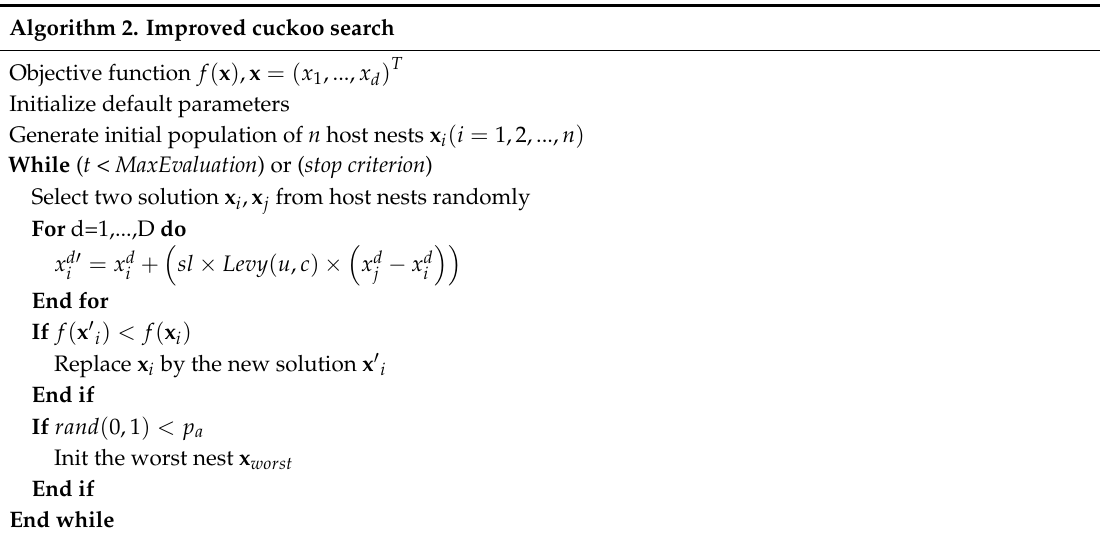
Algorithm 2. Improved cuckoo